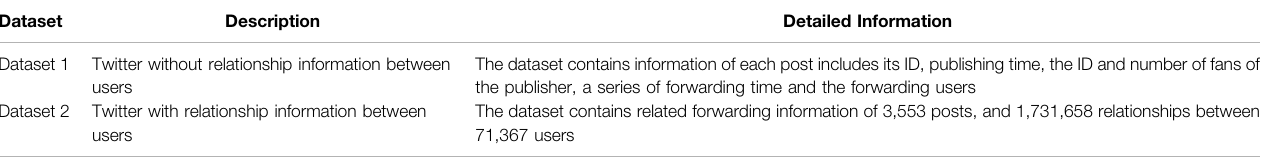
TABLE 2 | Statistics of datasets.